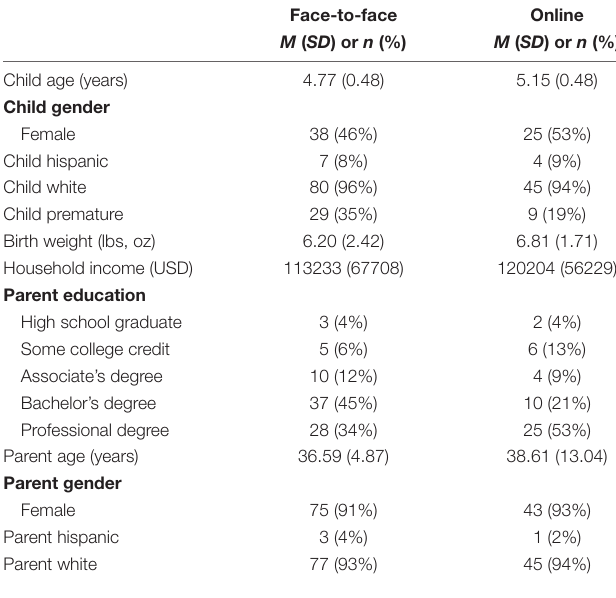
TABLE 1 | Demographic information for face-to-face ( N = 83) and online ( N = 48)